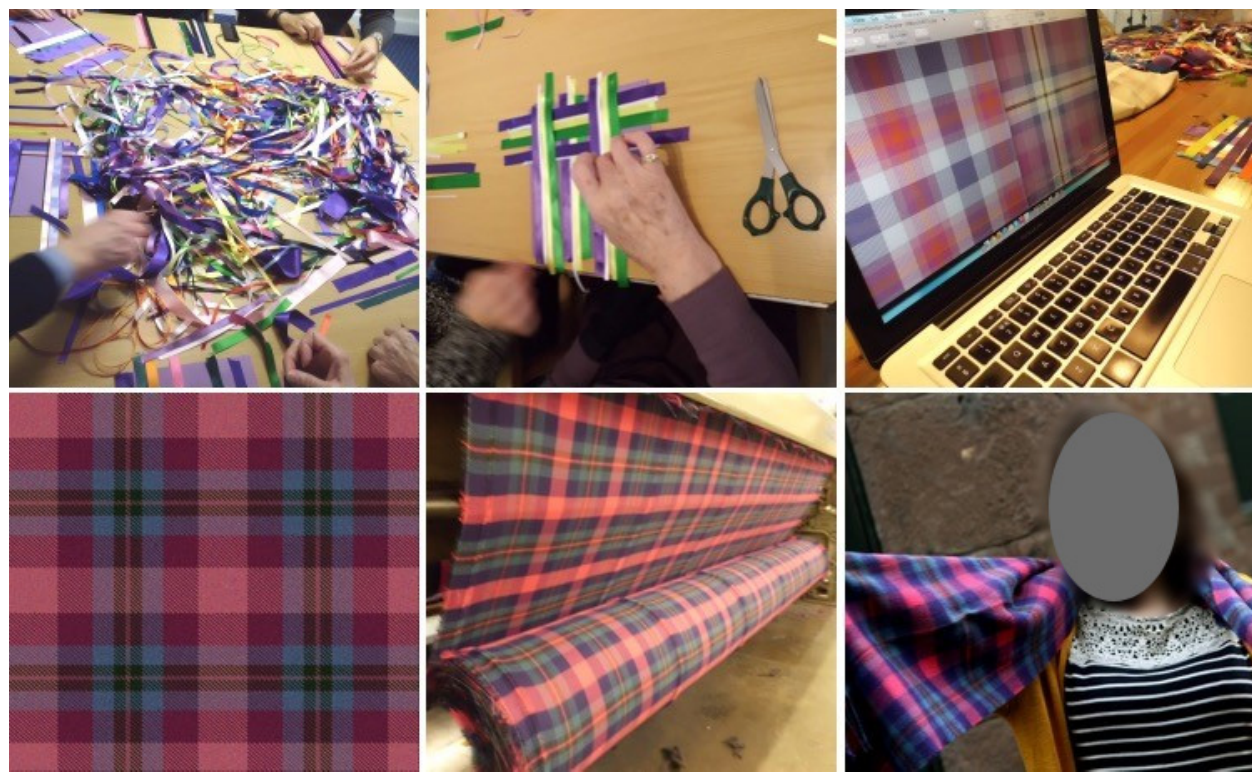
Figure 3. Disrupting Dementia tartan design process ( left to right , top to bottom : coloured ribbon physical prototypes; initial digital prototypes; tartan manufacture; end product) .